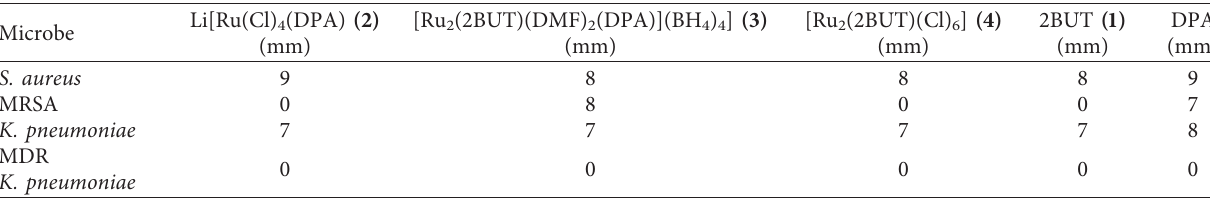
Table 6: Zones of inhibition of all compounds.